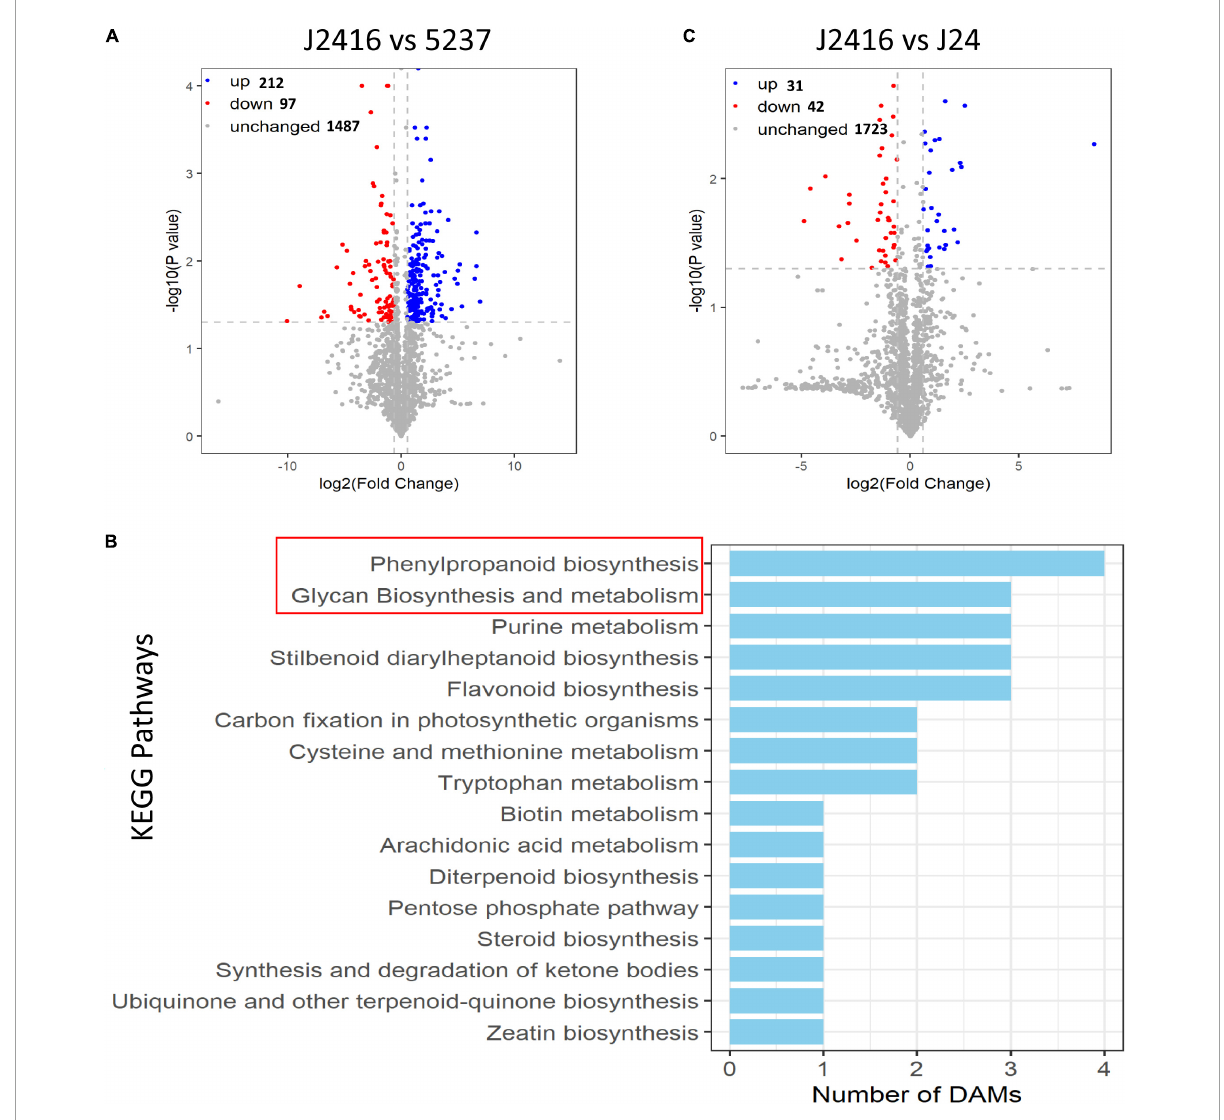
FIGURE4 Differentially accumulated metabolites (DAMs). (A) Volcano plot of differentially accumulated metabolites between J2416 and 5237. Blue and red dots represent significantly up- and down-regulated metabolites, respectively, in J2416 compared with 5237. (B) KEGG pathways enriched with up-regulated metabolites in J2416. (C) (A) Volcano plot of differentially accumulated metabolites between J2416 and